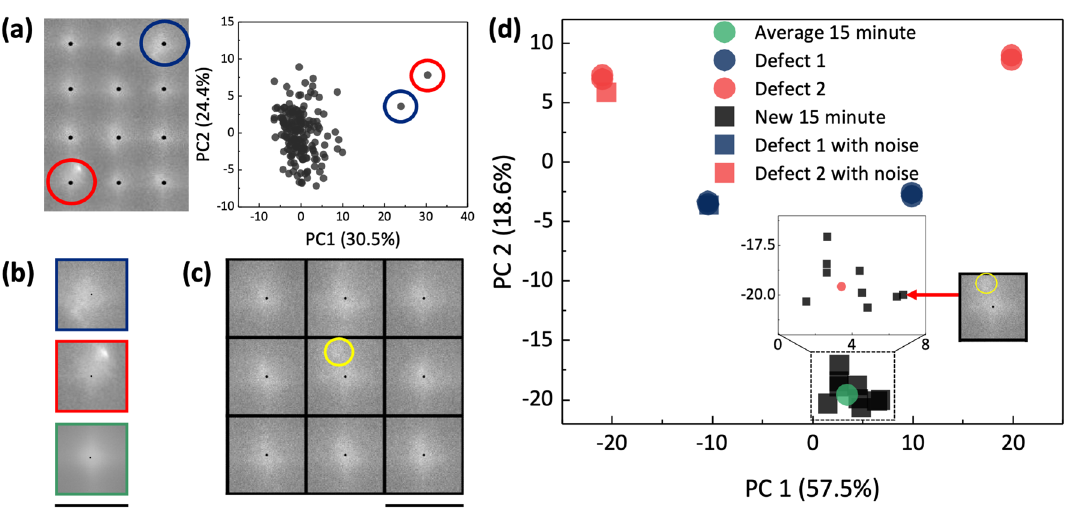
Figure 7. Illustration of defect detection scheme. ( a ) Naïve PCA on surface of a single 15 min-annealed structure detected two defects. The database is constructed with rotationally variated (90 ◦ , 180 ◦ , and 270 ◦ ) blue and red defects shown in ( b ). ( b ) Surface window of detected defects. Customized defect database was constructed using these two defects and one averaged surface of all windows of 15 min-annealed structure. ( c ) A segment of new 15-min structure for defect analysis on customized defect database. The yellow circle denotes presence of defect. ( d ) Defect analysis on customized database. While surfaces similar to defects 1 and 2 were classified as defects, all individual surfaces of new 15 min-annealed device were classified as regular 15 min- annealed surfaces. All scale bars are 10 µ